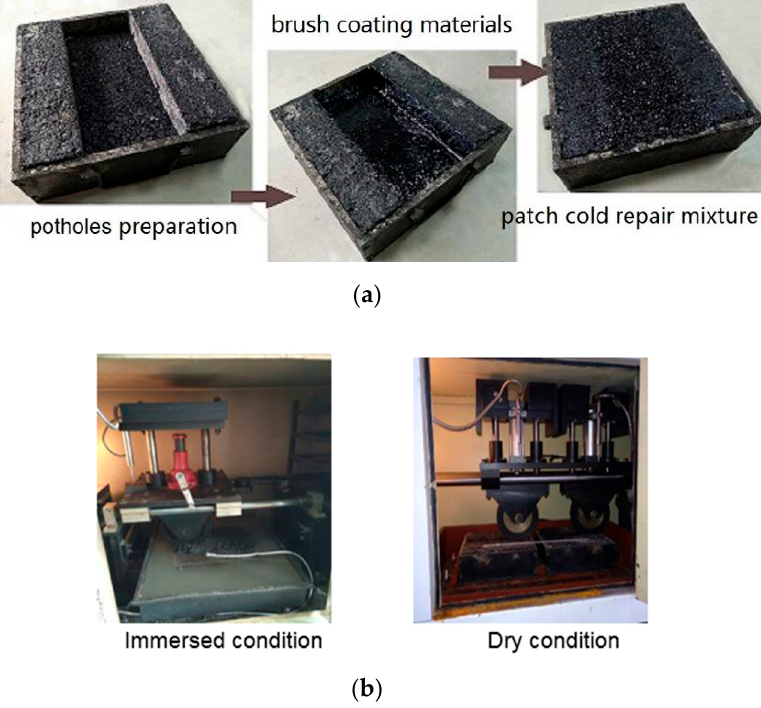
Figure 7. Accelerated loading tests: ( a ) The sample fabrication process of potholes patching durability tests; ( b ) accelerated loading tests device.